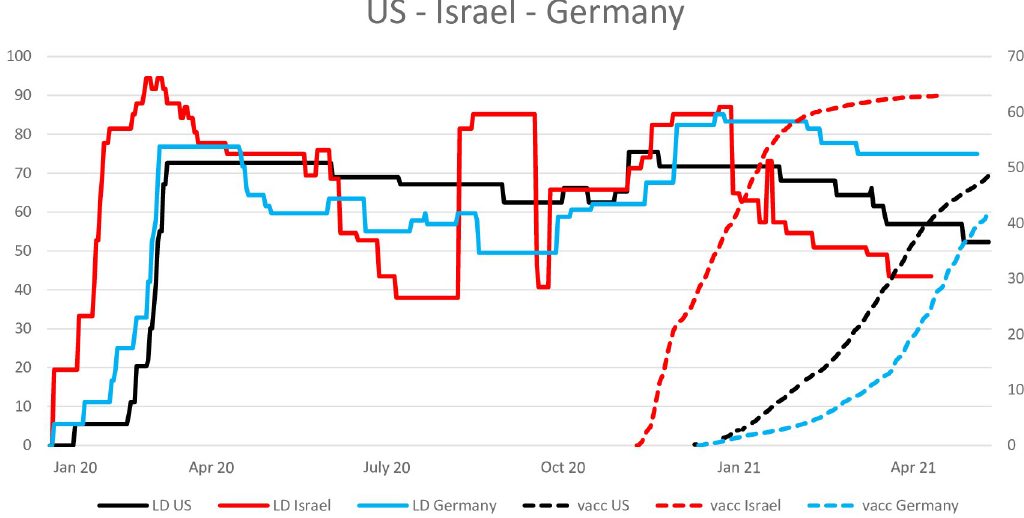
Fig 1. US, Israel and Germany. Lockdown intensity and proportion of vaccinated